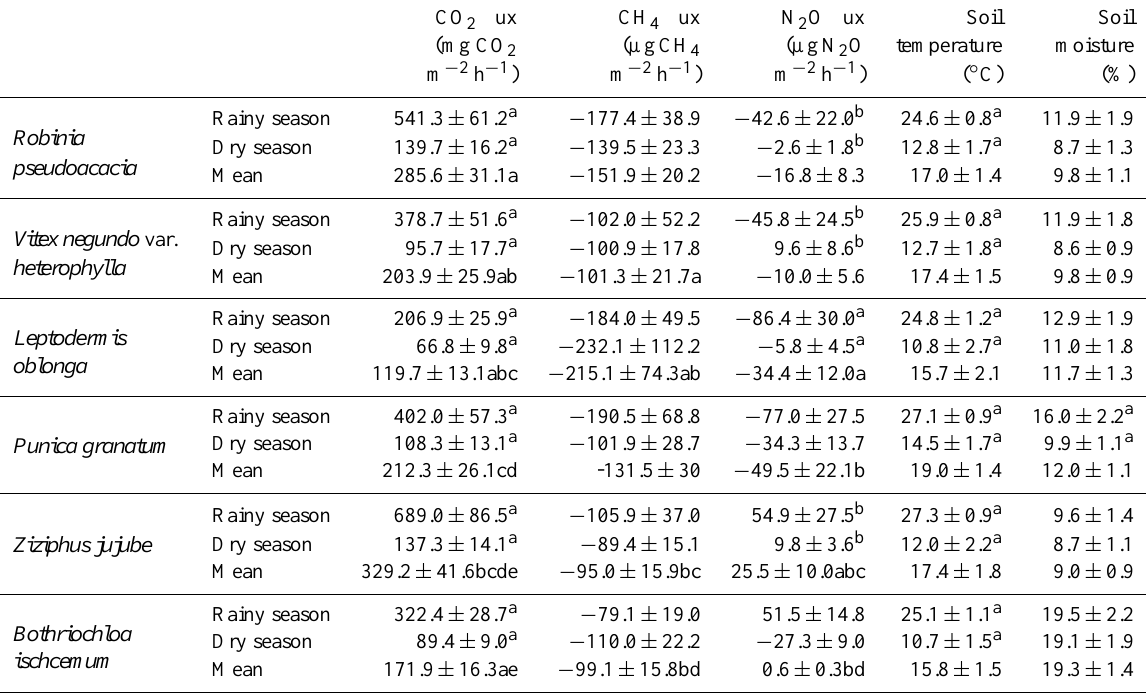
Table 3. Effects of season, tree species on GHG fluxes, soil temperature, and soil moisture (mean ± S.E.) of six tree species.